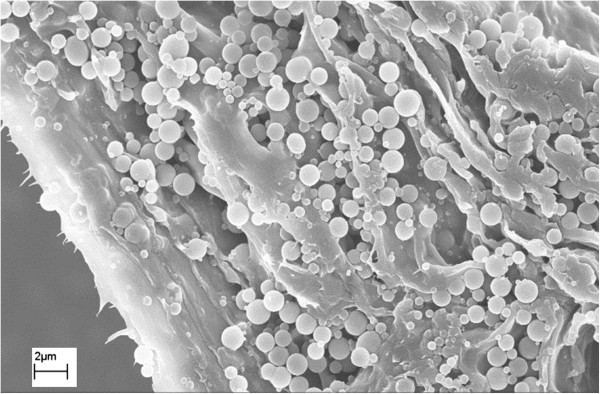
SEM image of pseudo-lignin deposition on surface of poplar holocellulose after dilute acid pretreatment.